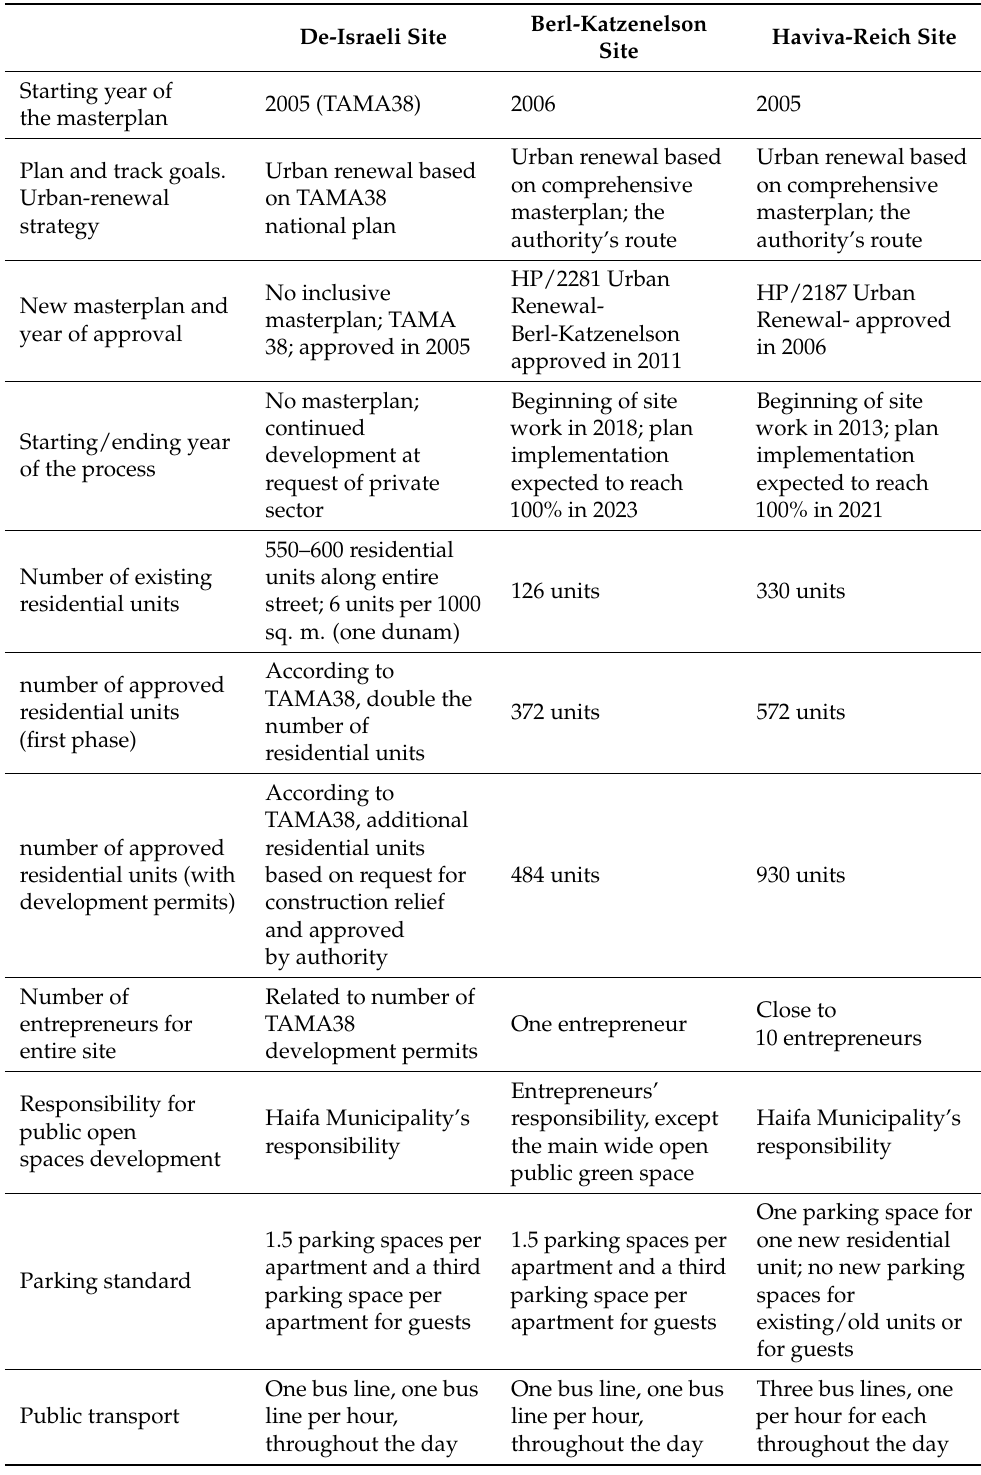
Table 1. Comparable evaluation of quantitative parameters between the three case studies. De-Israeli